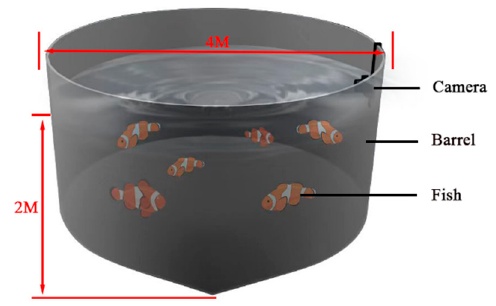
Figure 1. The experimental setup of image acquisition.